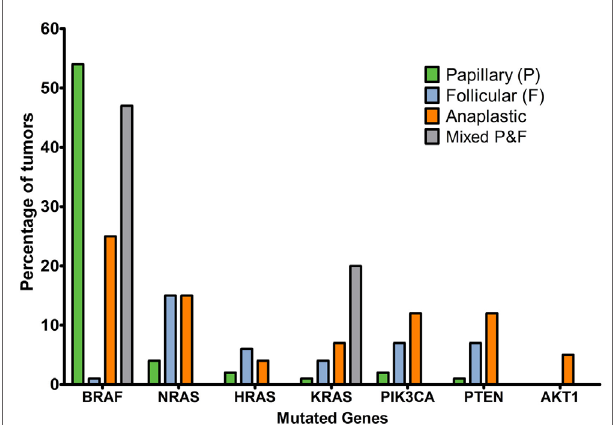
FiGURe 2 | Percentage of tumors with mutations affecting MAPK or Pi3K/Akt signaling pathways in thyroid cancer histotypes of follicular cell origin . Data obtained from the COSMIC, 2014 (32) database considering the top 20 mutations (accessed 16/12/2015). Numbers of samples: papillary, 19239; follicular, 253; anaplastic, 564; mixed papillary and follicular,